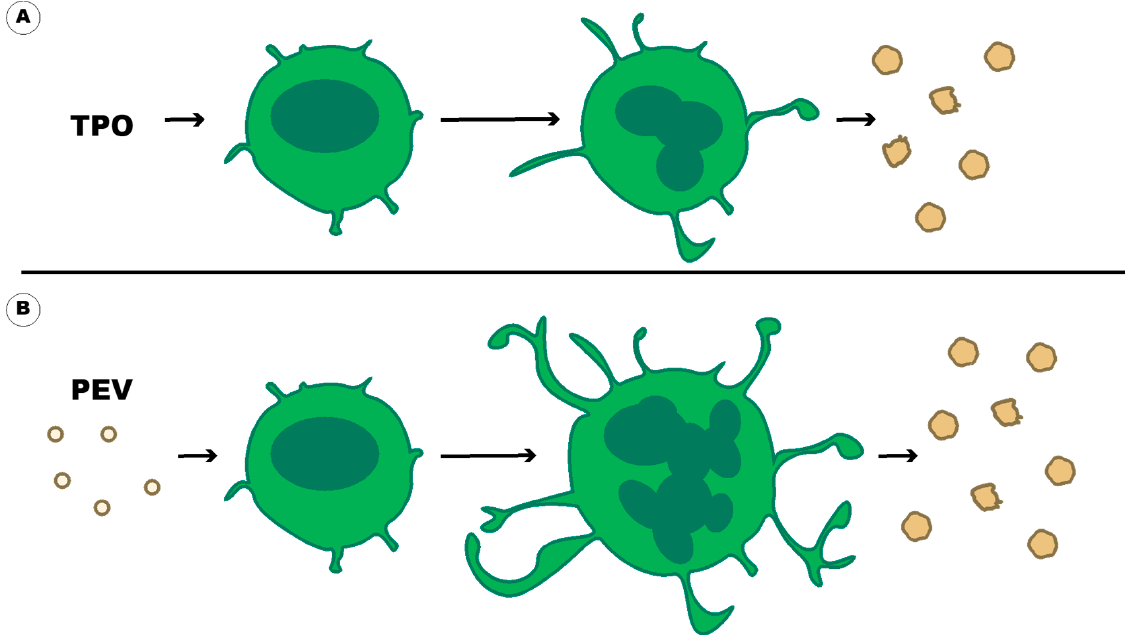
Figure 6. Platelet Extracellular Vesicles (PEVs) Stimulate Megakaryocyte Maturation and Platelet Production . ( A ). Megakaryopoiesis is normally induced by thrombopoietin (TPO), where megakaryocytes become polyploid and platelets are produced from pseudopodia extending from the mature megakaryocyte. ( B ). PEVs can stimulate megakaryopoiesis independent of TPO. When PEVs stimulate megakaryocyte maturation and platelet production, the resulting megakaryocytes are larger and more polyploid and as a result, there is increased platelet production.